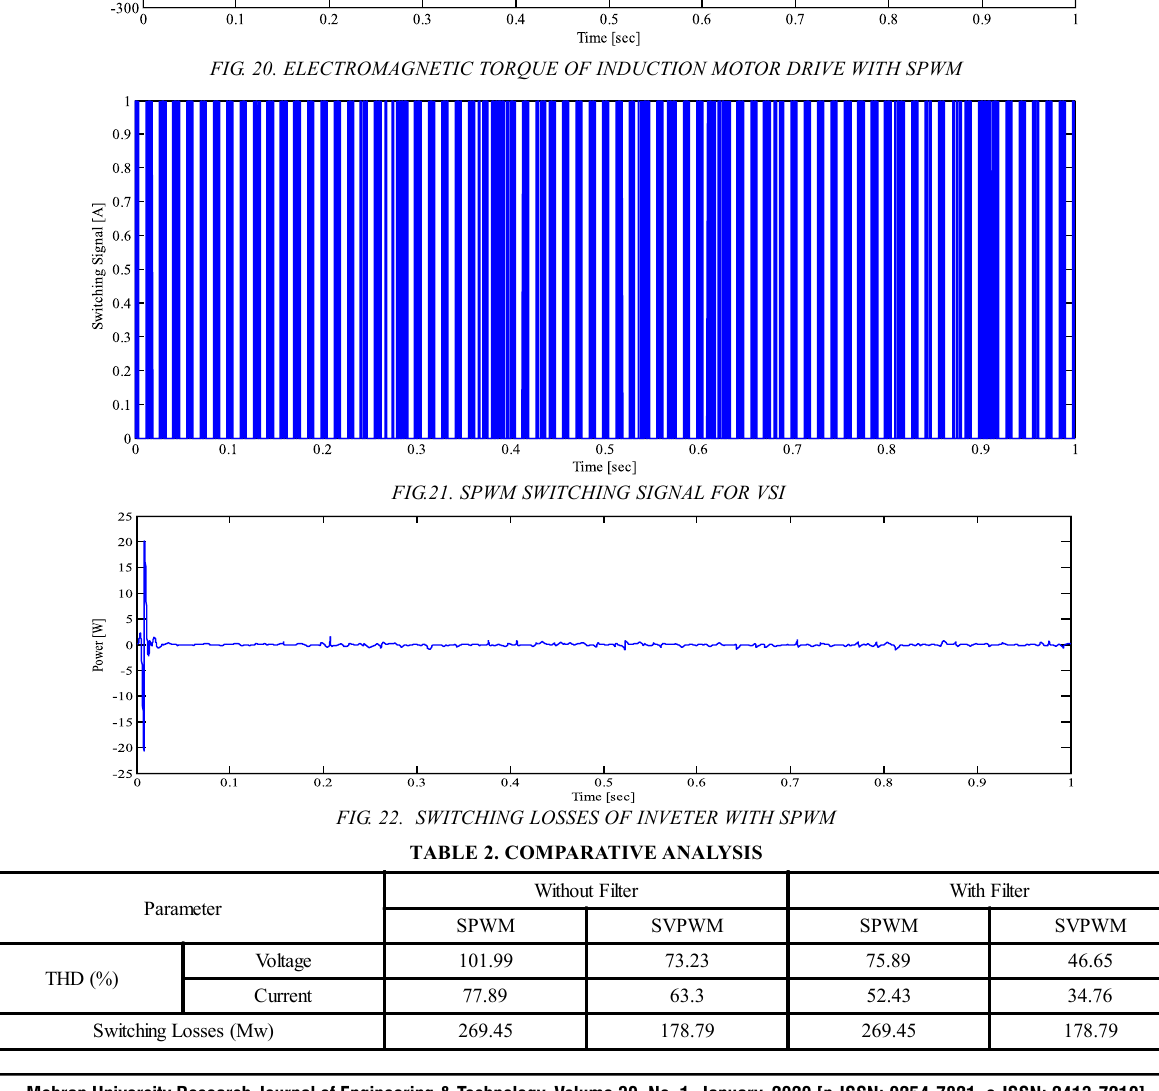
FIG. 22. SWITCHING LOSSES OF INVETER WITH